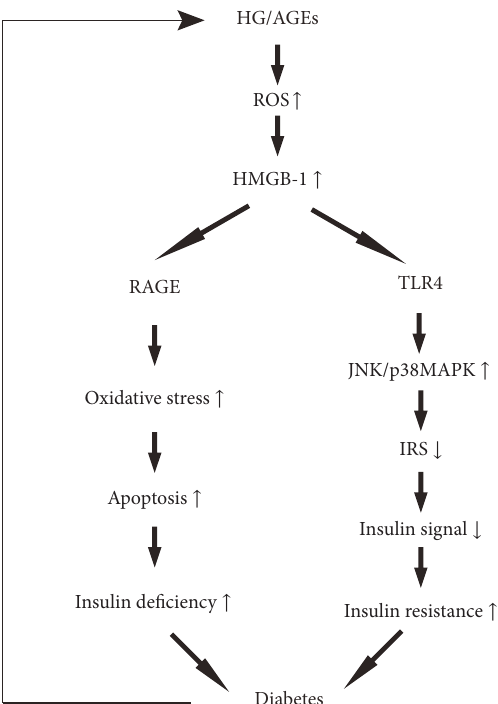
Figure 2: Schematic representation of HMGB-1-mediated cellular signaling pathways in islet